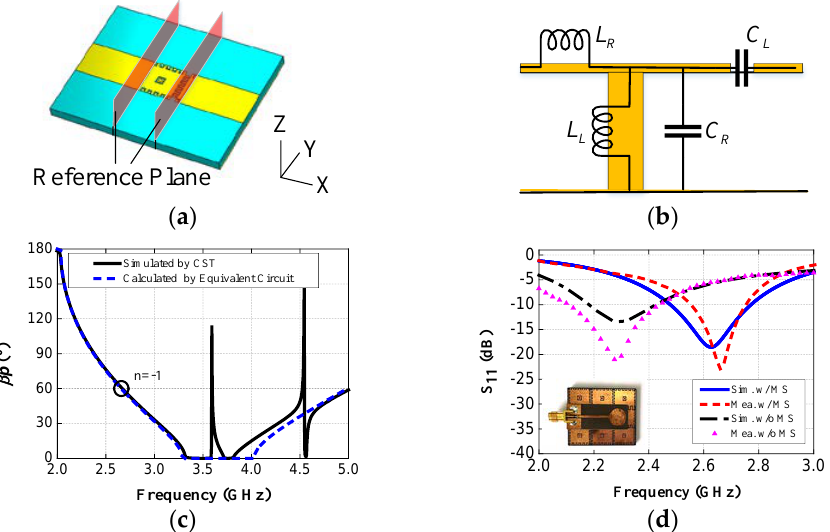
Figure 8. ( a ) Simulation model of dispersion of unit cell of the metasurface antenna. ( b ) The equivalent circuit of metasurface unit cell. ( c ) The dispersion curve simulated by CST and calculated by an equivalent circuit. ( d ) The photo of the compact, low-profile metasurface antenna and its S11 curve when feeding structure with/without metasurface plane [5].